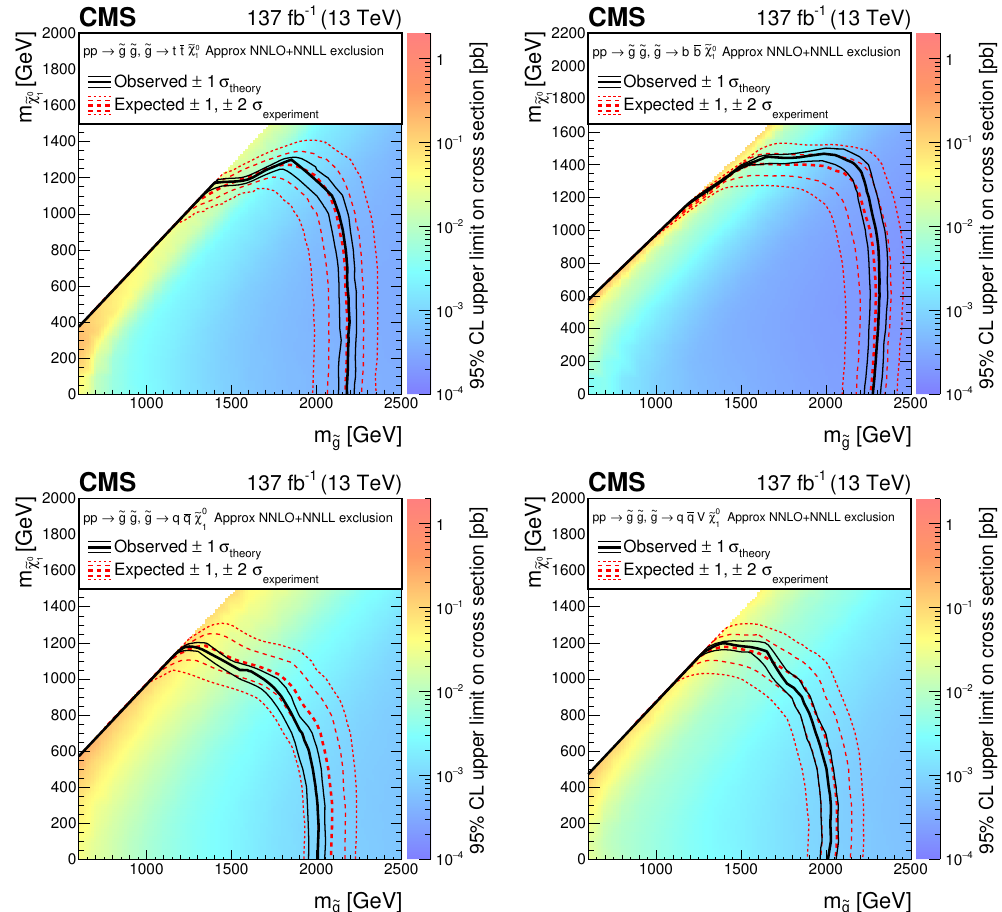
Figure 13 . The 95% CL upper limits on the production cross sections of the (upper left) T1tttt, (upper right) T1bbbb, (lower left) T1qqqq, and (lower right) T5qqqqVV signal models as a function of the gluino and LSP masses m and m . The thick solid (black) curves show the observed 0 e g 1 e (cid:31) exclusion limits assuming the approximate-NNLO+NNLL cross sections [73{84]. The thin solid (black) curves show the changes in these limits as the signal cross sections are varied by their theoretical uncertainties [102]. The thick dashed (red) curves present the expected limits under the background-only hypothesis, while the two sets of thin dotted (red) curves indicate the region containing 68 and 95% of the distribution of limits expected under this